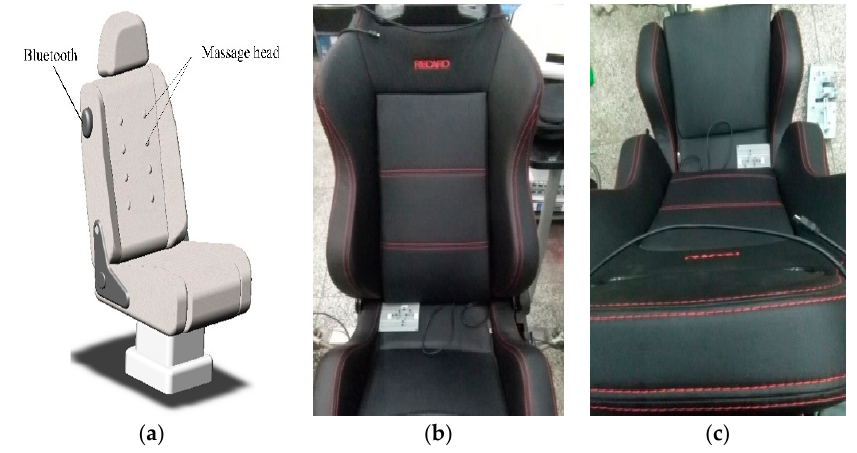
Figure 10. High-speed train driver’s fatigue warning device. ( a ) The model of vibrate chair; ( b ) Experimental massage chair in the test; ( c ) Experimental massage chair in the test.